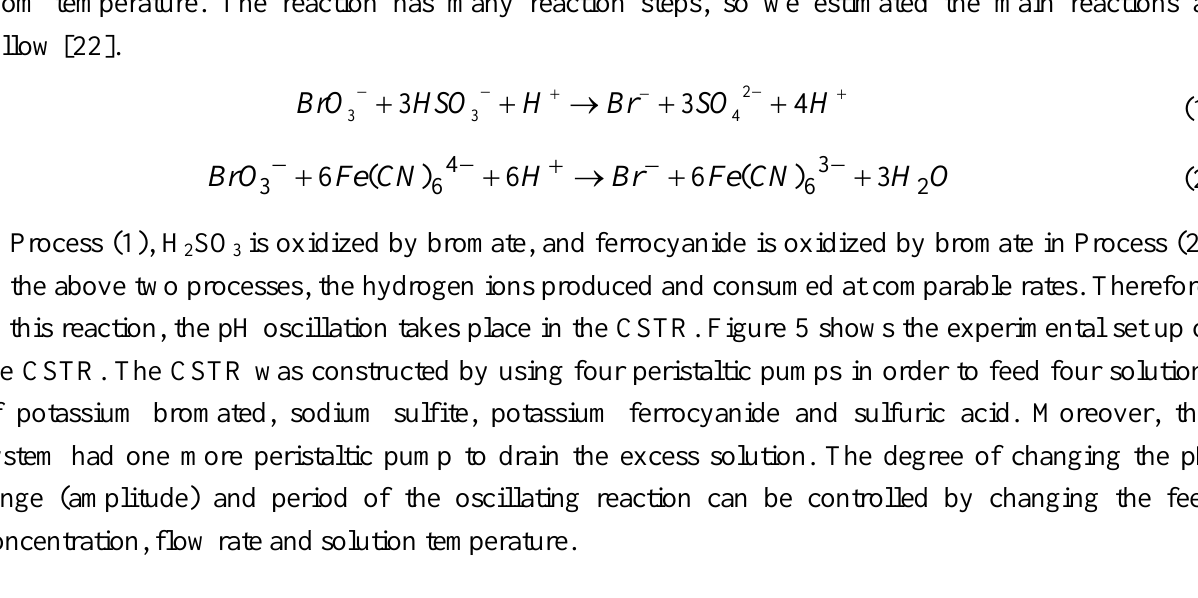
Figure 5. Continuous monitoring system for oscillation: monitoring both the medium pH and the gel motion in a